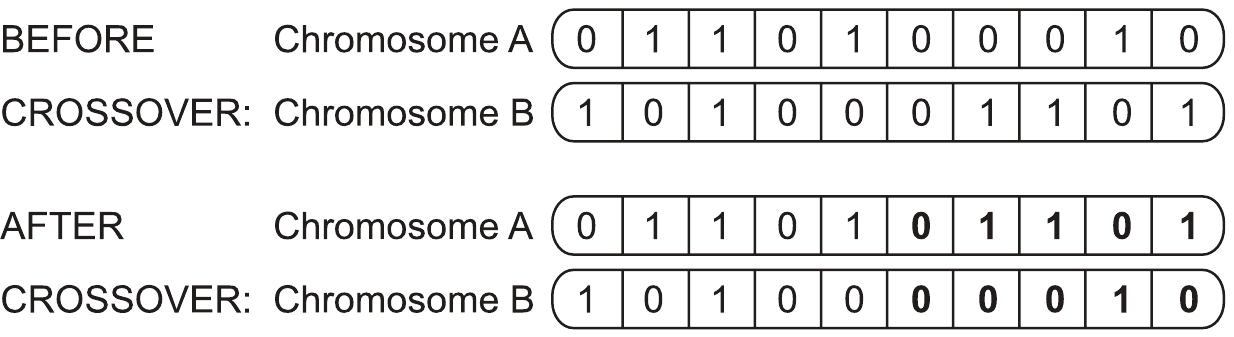
Figure 1. Example of crossover between two binary-coded chromosomes. An example of crossover between a set of two binary-coded chromosomes where half the length of chromosome A is exchanged for half the length of chromosome B , resulting in a hybrid set of